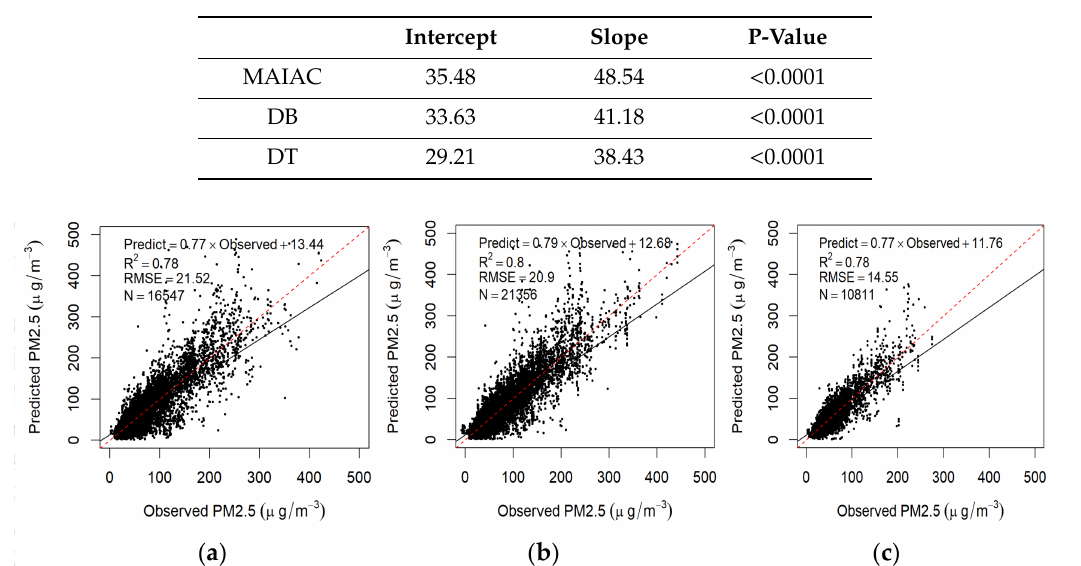
Table 3. Fixed intercept and slope of the linear mixed e ff ects model.